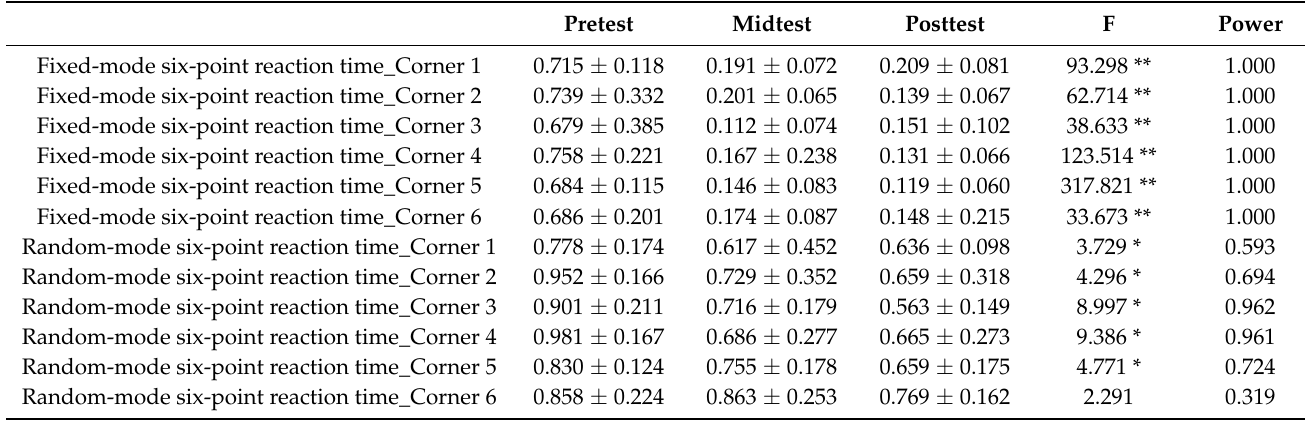
Table 2. Reaction times for footwork movements in six-point positions in fixed and random modes.